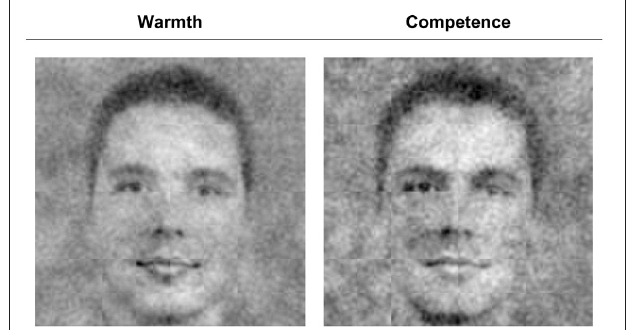
FIGURE 5 | Control classification images for warmth and competence by three hypotheses-blind participants.